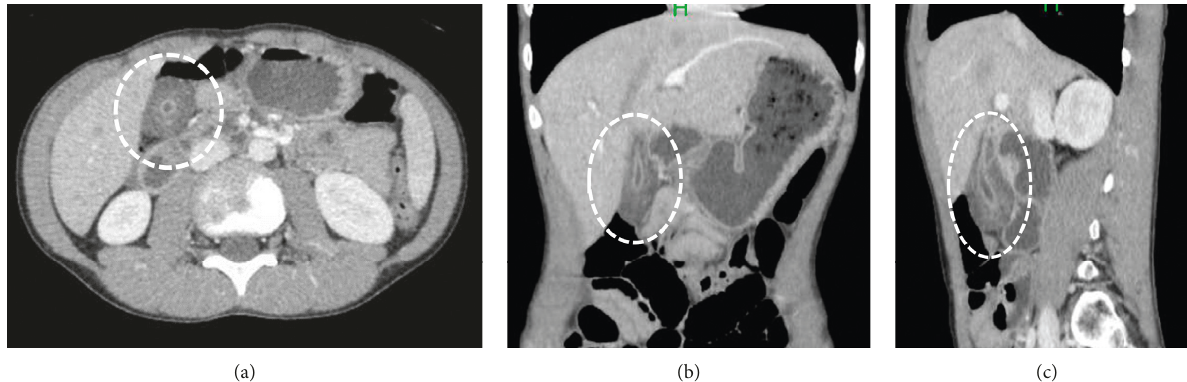
Figure 1: Abdominal contrast-enhanced computed tomography revealed a circular solid mass-like lesion (circle) near the normal-looking gallbladder on admission: (a) axial view, (b) coronal view, and (c) sagittal view.